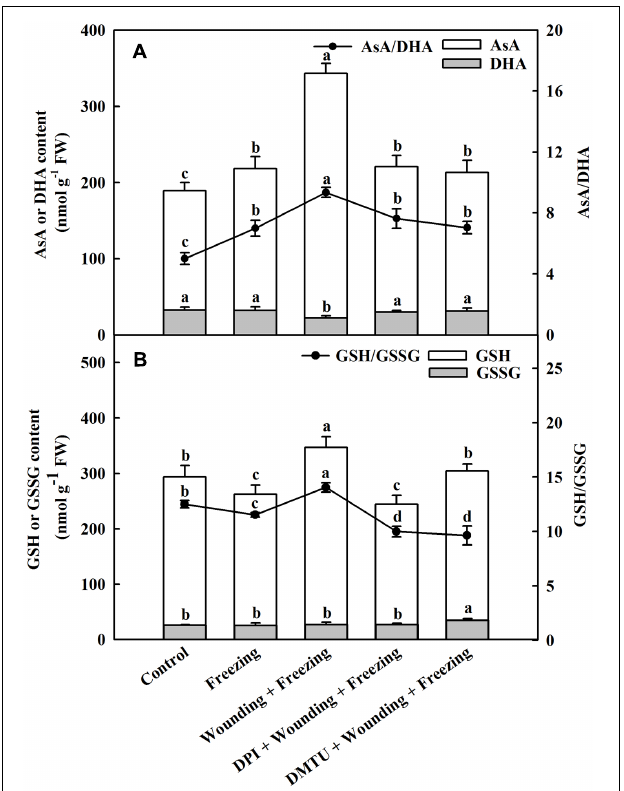
FIGURE 7 | Effect of mechanical wounding on AsA–GSH cycle in the systemic leaves of wheat under freezing stress. Ascorbate (AsA) and dehydroascorbate (DHA) content, ratio of AsA to DHA (A) . Glutathione (GSH) and glutathione disulfide (GSSG) content, ratio of GSH to GSSG (B) . The local (fifth) leaves were separately pre-treated with distilled water, 5 mM DMTU or 100 µ M DPI prior to wounding. At 10 days after wounding, the seedlings were exposed to freezing stress for 24 h. After 24 h recovery, the systemic (sixth) leaves were collected and AsA, DHA, GSH, and GSSG contents were determined. Data are mean values ± SD for three independent replicates. Means denoted by different letters indicated significant difference at P < 0.05 according to Tukey’s test.